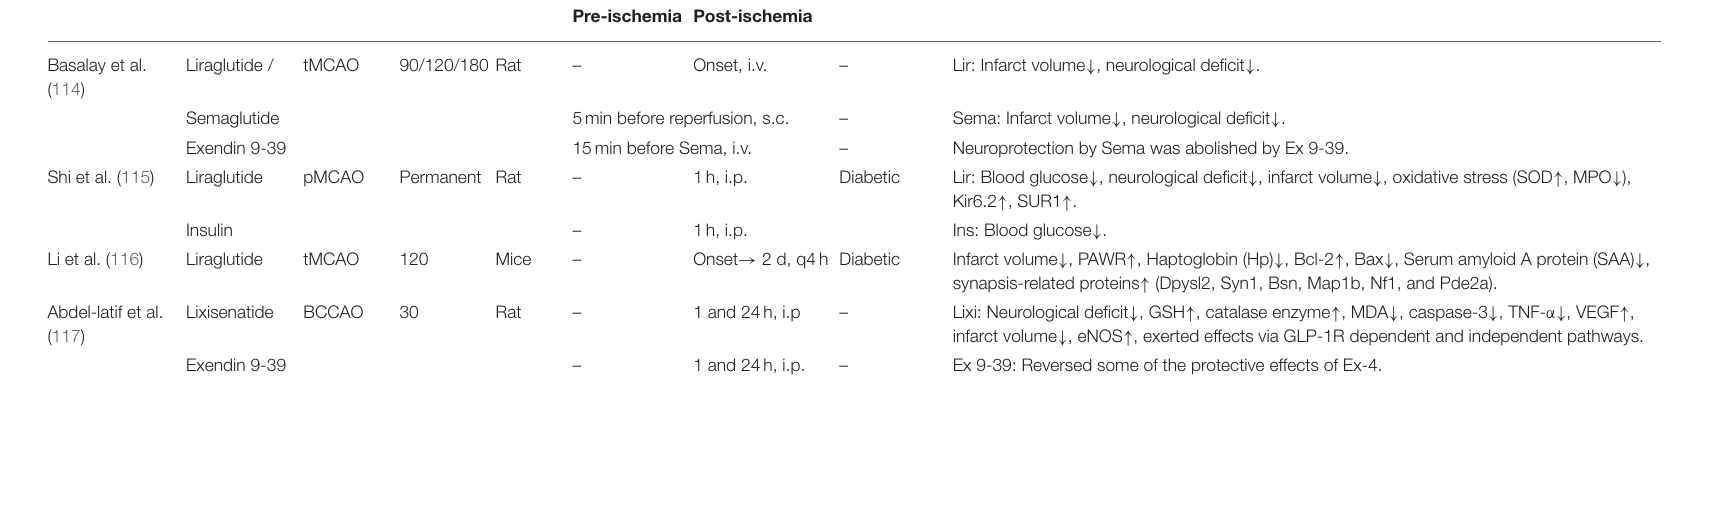
Lixi: Neurological deficit ↓ , GSH ↑ , catalase enzyme ↑ , MDA ↓ , caspase-3 ↓ , TNF- α ↓ , VEGF ↑ , infarct volume ↓ , eNOS ↑ , exerted effects via GLP-1R dependent and independent pathways. – 1 and 24h, i.p. – Ex 9-39: Reversed some of the protective effects of